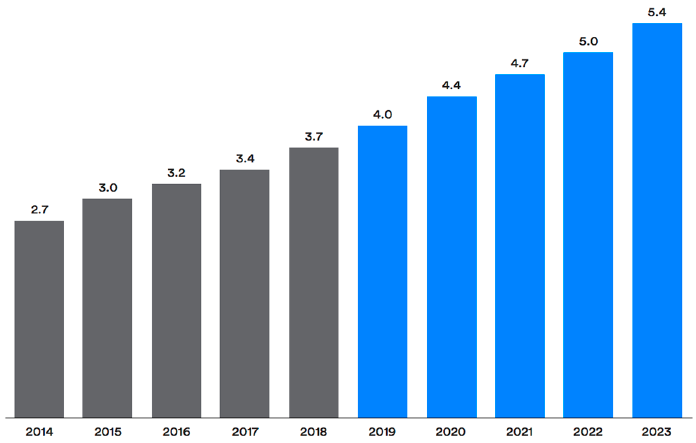
Figure 1. Annual Bluetooth device shipments (in billions) [2].